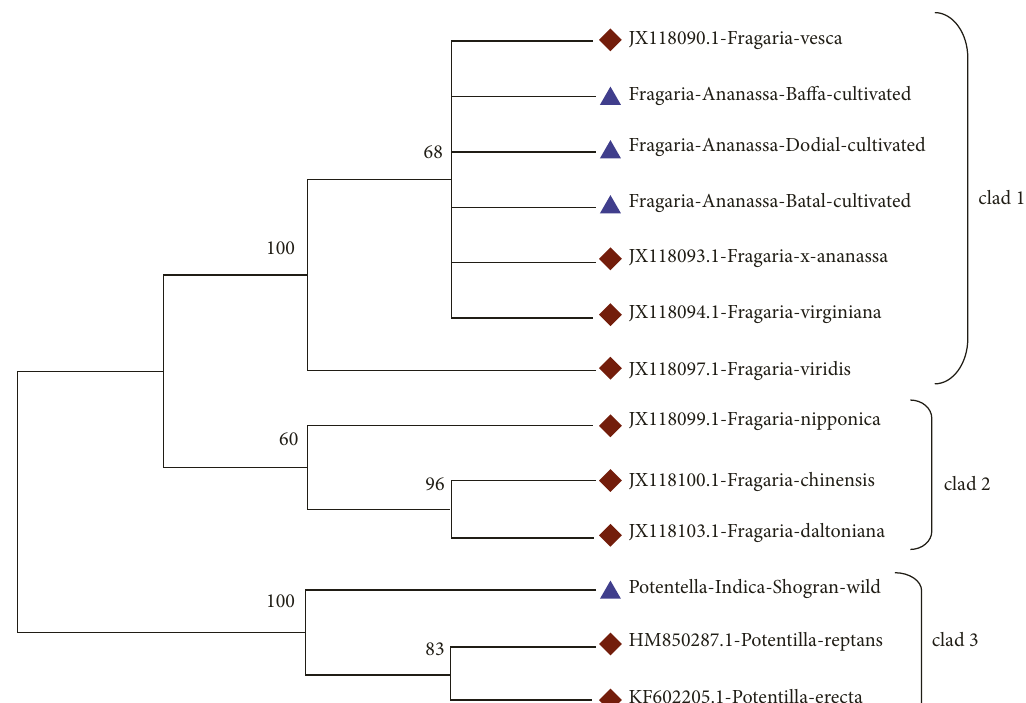
Figure 16: Phylogenetic tree of selected Fragaria ( rbclC ) species with related reference sequences through the neighbor-joining method.